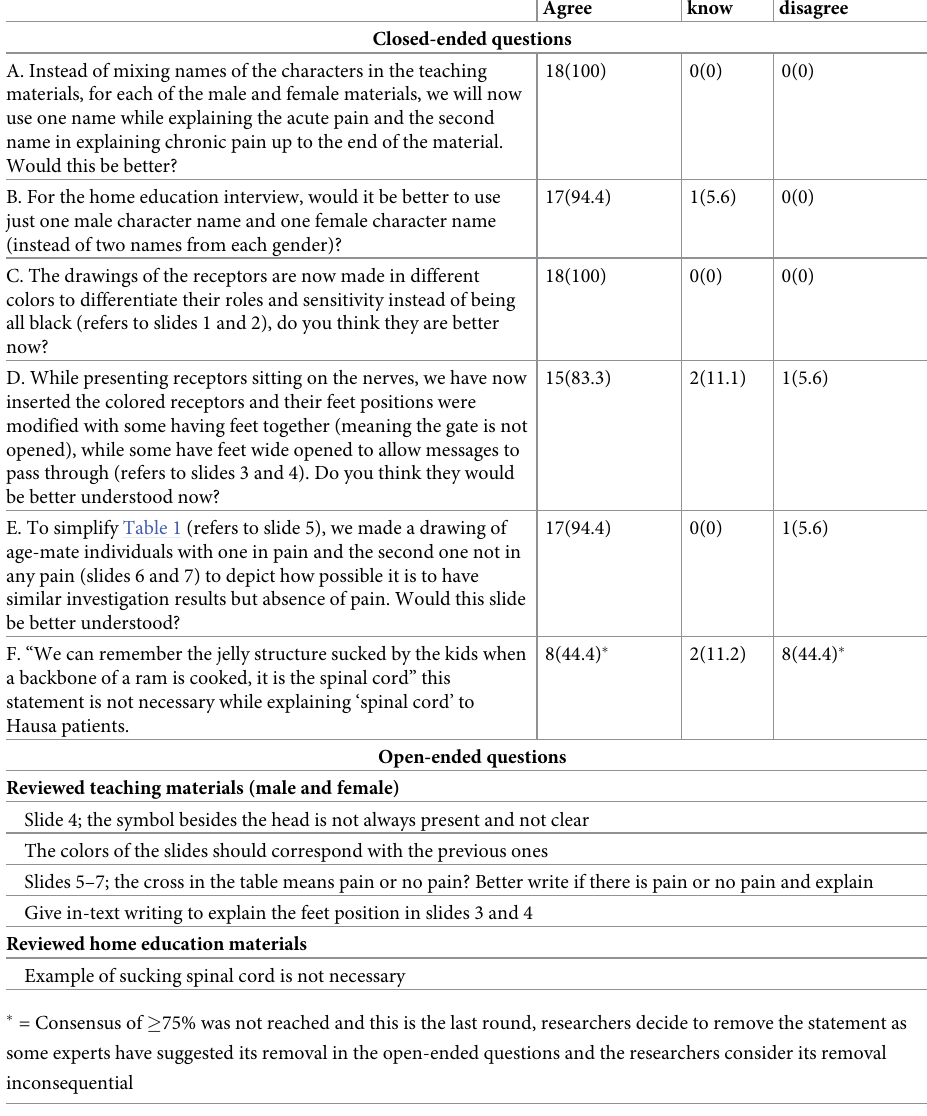
Table 5. Results of the Delphi round 3 (final round) closed-ended and open-ended questions for the reviewed home education material and teaching materials (n = 18).